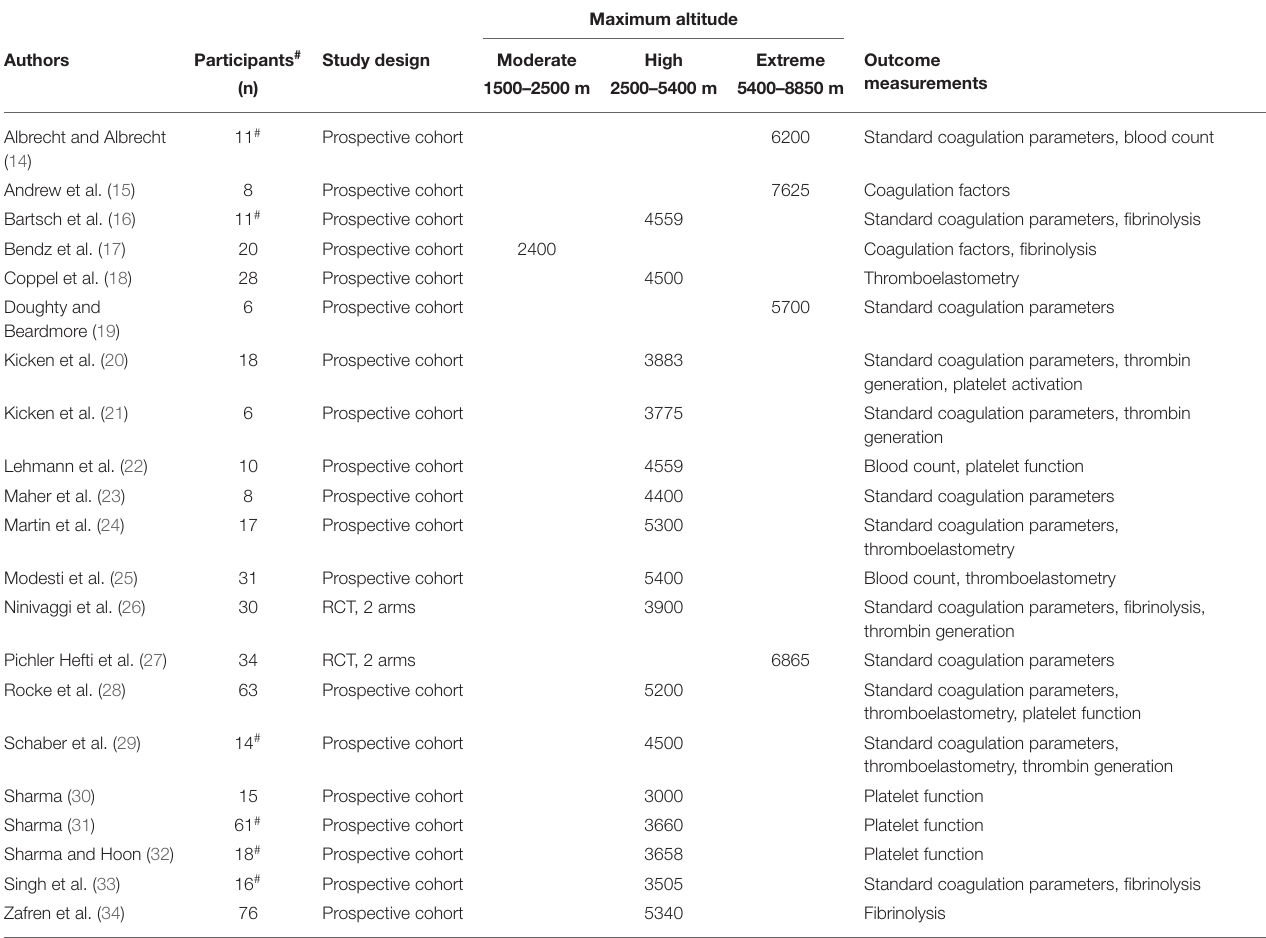
TABLE 1 | Overview of the 21 included studies ( N =